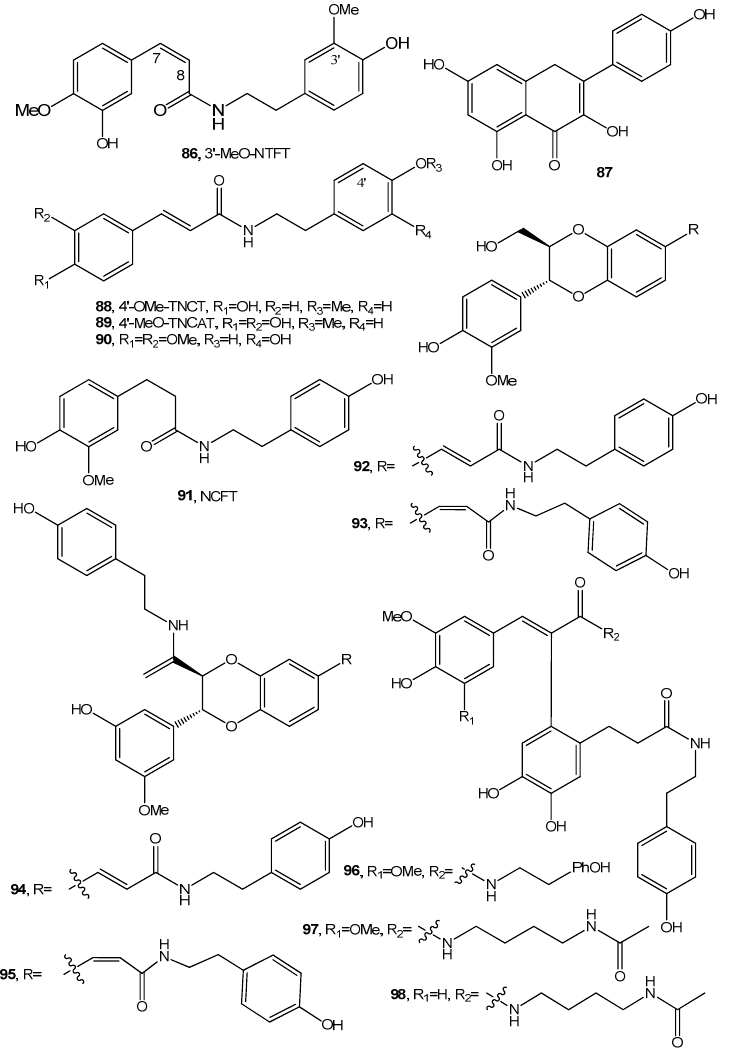
Figure 7 . The structures of compounds 86 – 98 . Figure 7. The structures of compounds 86 – 98 NTCT, NTFT, NTCAT and N - cis -feruloyloctopamine (NCFO ( 91 , Figure 7)) were iso- lated together with 7 new neolignanamides ( 92 – 98 , Figure 7), a new lignanamide ( 99 , Fig- ure 8) and 17 known phenolic compounds from the organic extract of Lycium chinense [83]. This plant belongs to genus Lycium (Solanaceae family) mainly distributed in South Amer- ica, South Africa and temperate Europe and Asia. It was used in traditional Chinese med- icine as an antipyretic and for the treatment of pneumonia, night-sweats, cough, hema- temesis, inflammation and diabetes mellitus [84]. The known compounds were identified as thoreliamide B, gentisic, vanillic, p -coumaric caffeic, ferulic, sinapic and dihydrocaffeic acids, as well as isoscopoletin, fraxidin, aquillochin, scopolin, kaempferide, apigenin and luteolin. The cinnamic acid amides, neolignanamides and lignanamides showed moder- ate radical scavenging activity towards the DPPH and superoxide radicals [83]. NTCT and NTFT were isolated from the organic extract of P. oleracea ( Portulacaceae) together with a pyrrole alkaloid named portulacaldehyde ( 100 , Figure 8), N -( E )-feruloyl- 4- O -methyldopamine ( 101 , Figure 8) and the well-known ( E )- p -coumaric and ( E )-ferulic acids, 4-hydroxybenzaldehyde, 2,4-dihydroxybenzaldehyde, 2-hydroxy-4-methoxyben- zoic and syringic acids [85]. P. oleracea , commonly named purslane, is an annual, semi- succulent, trailing herbaceous plant used in folk medicine for its analgesic and wound- healing, anti-inflammatory properties [86,87]. N -( E )-feruloyl-4- O -methyldopamine ( 101 ),